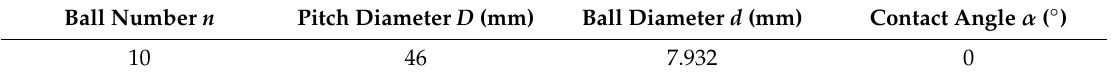
Table 8. Bearing parameter in this experiment.